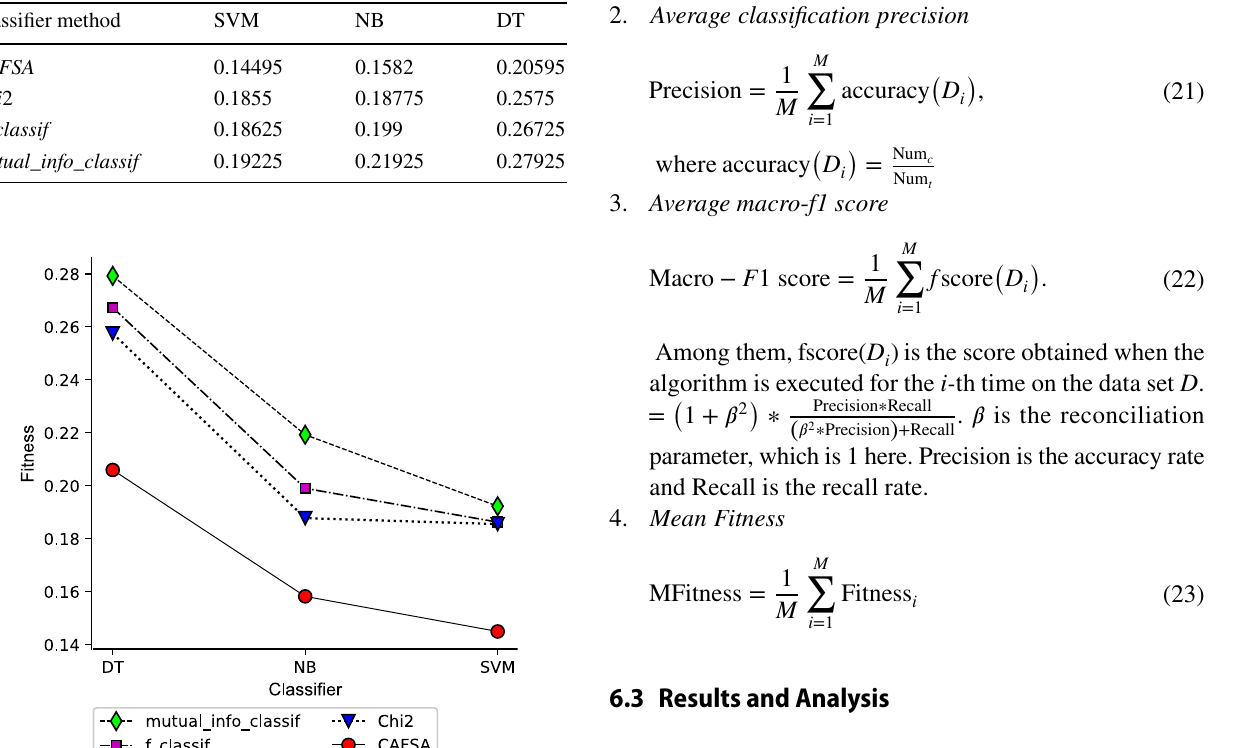
Table 8 Classic feature selection method and CAFSA experimental results on ChnSenticorp_Hotel dataset